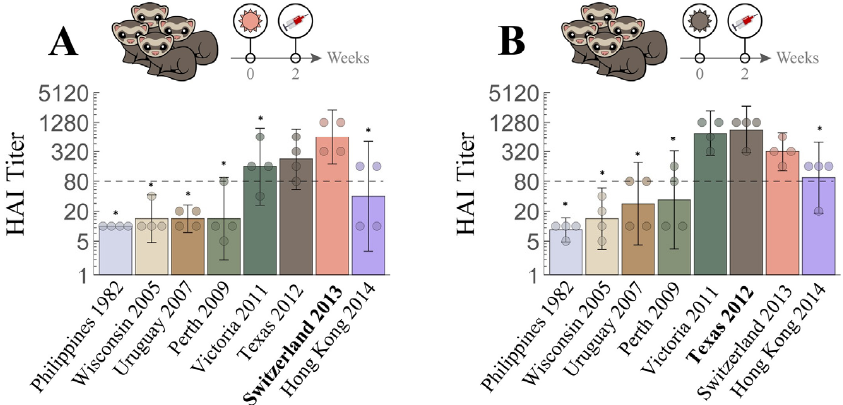
infected with V 1 = Uruguay 2007 , V 2 = Texas 2012 , V 3 = Switzerland 2013 , and V 4 = Hong the final infection with Hong Kong 2014. Individual HAI titers are shown from four ferrets (points) the final infection with Hong Kong 2014. Individual HAI titers are shown from four ferrets (points) , ( C ) V 2 = Texas 2012 , and ( D ) V 1 = Uruguay 2007 . All antisera were analyzed via HAI after infected with ( A ) V 4 = Hong Kong 2014 , or with prior exposure to ( B ) V 3 = Switzerland 2013 2014 . HAI titers are shown for each step of the infection: ( A ) V 1 , ( B ) V 1 → V 2 , ( C ) V 1 → V 2 → V 3 , and Kong 2014 . HAI titers are shown for each step of the infection: ( A ) V 1 , ( B ) V 1 → V 2 , ( C ) and geometric means (bar graphs) with 95% confidential intervals (error bars). * indicates p < 0.05 and geometric means (bar graphs) with 95% confidential intervals (error bars). * indicates p < 0.05 the final infection with Hong Kong 2014. Individual HAI titers are shown from four ferrets (points) Kong 2014 . HAI titers are shown for each step of the infection: ( A ) V 1 , ( B ) V 1 → V 2 , ( C ) ( D ) V 1 → V 2 → V 3 → V 4 . Individual HAI titers are presented from four ferrets (points) with geometric V 1 → V 2 → V 3 , and ( D ) V 1 → V 2 → V 3 → V 4 . Individual HAI titers are presented from four ferrets (points) , ( C ) V 2 = Texas 2012 , and ( D ) V 1 = Uruguay 2007 . All antisera were analyzed via HAI after vs. Hong Kong 2014 by Mann–Whitney test after data were log transformed. ( E – H ) Each set of meas- vs. Hong Kong 2014 by Mann–Whitney test after data were log transformed. ( E – H ) Each set of meas- and geometric means (bar graphs) with 95% confidential intervals (error bars). * indicates p < 0.05 V 1 → V 2 → V 3 , and ( D ) V 1 → V 2 → V 3 → V 4 . Individual HAI titers are presented from four ferrets (points) means (bar graphs) and 95% confidential intervals (error bars). * indicates p < 0.05 vs. Uruguay the final infection with Hong Kong 2014. Individual HAI titers are shown from four ferrets (points) with geometric means (bar graphs) and 95% confidential intervals (error bars). * indicates p < 0.05 urements was decomposed to determine the antibody signatures (the HAI profiles of the dominant urements was decomposed to determine the antibody signatures (the HAI profiles of the dominant vs. Hong Kong 2014 by Mann–Whitney test after data were log transformed. ( E – H ) Each set of meas- with geometric means (bar graphs) and 95% confidential intervals (error bars). * indicates p < 0.05 and geometric means (bar graphs) with 95% confidential intervals (error bars). * indicates p < 0.05 2007 by Mann–Whitney test after data were log transformed. ( E – H ) These measurements were vs. Uruguay 2007 by Mann–Whitney test after data were log transformed. ( E – H ) These measure- antibodies within these sera). Each antibody signature (gray) is predicted to have an HAI titer ≥ 80 antibodies within these sera). Each antibody signature (gray) is predicted to have an HAI titer ≥ 80 urements was decomposed to determine the antibody signatures (the HAI profiles of the dominant vs. Uruguay 2007 by Mann–Whitney test after data were log transformed. ( E – H ) These measure- vs. Hong Kong 2014 by Mann–Whitney test after data were log transformed. ( E – H ) Each set of meas- decomposed to determine the antibody signatures (the HAI profiles of the dominant antibodies) against any virus within the gray circle, with the size of this circle proportional to the fractional against any virus within the gray circle, with the size of this circle proportional to the fractional ments were decomposed to determine the antibody signatures (the HAI profiles of the dominant antibodies within these sera). Each antibody signature (gray) is predicted to have an HAI titer ≥ 80 ments were decomposed to determine the antibody signatures (the HAI profiles of the dominant urements was decomposed to determine the antibody signatures (the HAI profiles of the dominant elicited after infection with ( E ) V 1 followed by ( F ) V 2 , ( G ) V 3 , and ( H ) V 4 . Each antibody signature composition of the antibody signature within the serum. An antibody–virus distance d denotes an composition of the antibody signature within the serum. An antibody–virus distance d denotes an antibodies) elicited after infection with ( E ) V 1 followed by ( F ) V 2 , ( G ) V 3 , and ( H ) V 4 . Each antibody against any virus within the gray circle, with the size of this circle proportional to the fractional antibodies) elicited after infection with ( E ) V 1 followed by ( F ) V 2 , ( G ) V 3 , and ( H ) V 4 . Each antibody antibodies within these sera). Each antibody signature (gray) is predicted to have an HAI titer ≥ 80 HAI titer of 6000/2 d . HAI titer of 6000/2 d . (gray) is predicted to have an HAI titer ≥ 80 against any virus within the gray circle, with the size composition of the antibody signature within the serum. An antibody–virus distance d denotes an signature (gray) is predicted to have an HAI titer ≥ 80 against any virus within the gray circle, with signature (gray) is predicted to have an HAI titer ≥ 80 against any virus within the gray circle, with against any virus within the gray circle, with the size of this circle proportional to the fractional of this circle proportional to the fractional composition of the antibody signature within the serum. HAI titer of 6000/2 d . the size of this circle proportional to the fractional composition of the antibody signature within the the size of this circle proportional to the fractional composition of the antibody signature within the composition of the antibody signature within the serum. An antibody–virus distance d denotes an An antibody–virus distance d denotes an HAI titer of 6000/2 d . Virus coordinates were previously serum. An antibody–virus distance d denotes an HAI titer of 6000/2 d . Virus coordinates were previ- HAI titer of 6000/2 d . serum. An antibody–virus distance d denotes an HAI titer of 6000/2 d . Virus coordinates were previ- determined using a panel of monoclonal antibodies (see details in the main text). In Panels ( F – H ), ously determined using a panel of monoclonal antibodies (see details in the main text). In Panels F- ously determined using a panel of monoclonal antibodies (see details in the main text). In Panels F- infection with multiple viruses elicited both specific (HAI ≥ 80 against all infection strains) and H, infection with multiple viruses elicited both specific (HAI ≥ 80 against all infection strains) and H, infection with multiple viruses elicited both specific (HAI ≥ 80 against all infection strains) and non-specific antibody signatures. Arrows show the subtle shifts of the antibody signatures between non-specific antibody signatures. Arrows show the subtle shifts of the antibody signatures between non-specific antibody signatures. Arrows show the subtle shifts of the antibody signatures between Panels ( F ) → ( G ) → ( H ). Panels F → G → H. Panels F → G → H.